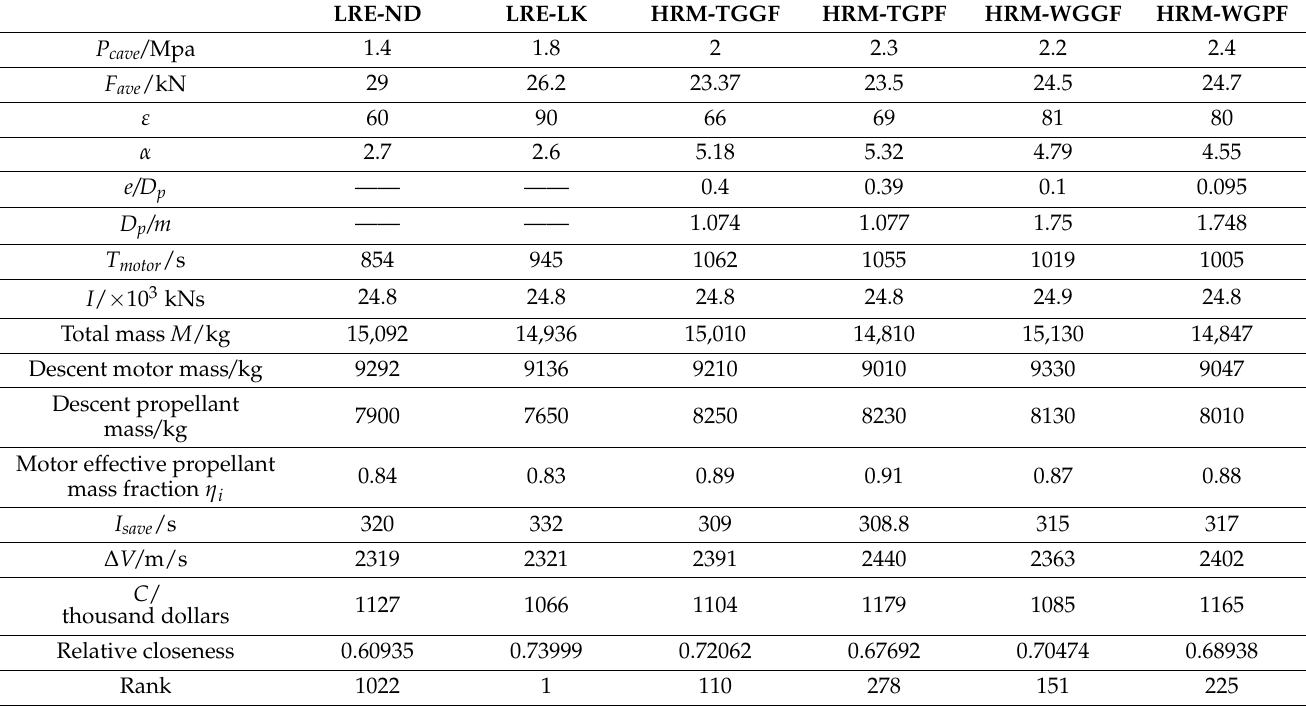
Table 6. Main performance of continuous attributes assessment